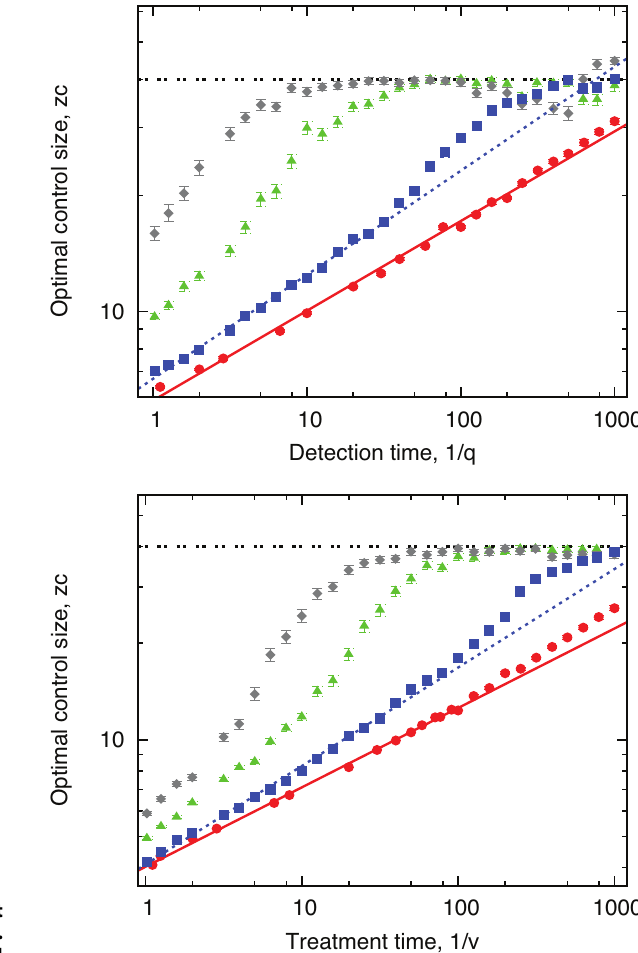
Figure 8. Relationship between z c and t q on top and t v on bottom for regular and small world network with varying number of long-range links. Lines and simulation points from bottom: red: regular network, navy blue: small world with additional 1% of links, green: small world with additional 5% of links, grey: small world with additional 10% of links, dashed black: z c ~ 40 which corresponds to treating the whole population. Simulation parameters: f ~ 1, v , r ~ 0 : 1, z inf ~ 1, 40 initial foci, 1%,5%,10% of long-range links.